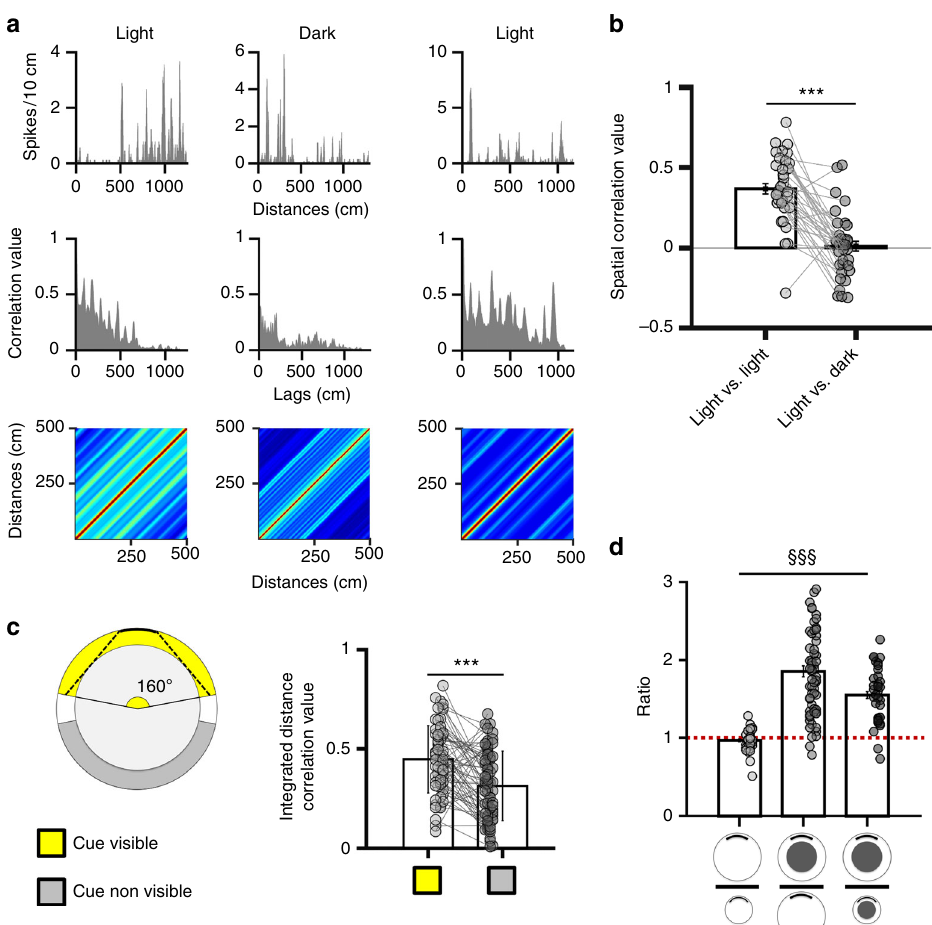
Fig. 5 Environmental features in fl uence grid cell activity. a Example of the activity of one grid cell linearized according to the path integrated distance model, in both light and dark conditions. Top row: fi ring rate; middle row: autocorrelation; bottom row: Toeplitz matrix. Note that the regularity is altered in darkness. b Average spatial correlation (±SEM) between the rate plots from all grid cells recorded in the two light sessions (light vs light) and in light vs dark sessions. Data from individual cells are shown in grey. *** p < 0.001, paired t -test. c Left: Diagram showing the two regions of the track in which the cue is visible (yellow) or not (grey). Note that an ambiguous zone (white) was excluded from the analysis, so that the areas of the visible-cue and non-visible- cue region are equivalent. Right: Correlation (±SD) between the integrated distance fi ring activity in the visible-cue and non-visible-cue region of the track. Data from individual cells are shown in grey. *** p < 0.001 paired t -test. d Ratio (±SEM) between grid cell fi eld distance in the arena and the track; the distance in the track is calculated based on the path integrated distance model. Dashed line indicates a ratio of 1 (i.e. same fi eld distance in the two environments). §§§ p < 0.001, repeated measure ANOVA. Note that grid cell fi eld distance is unchanged between large and small arenas, whereas